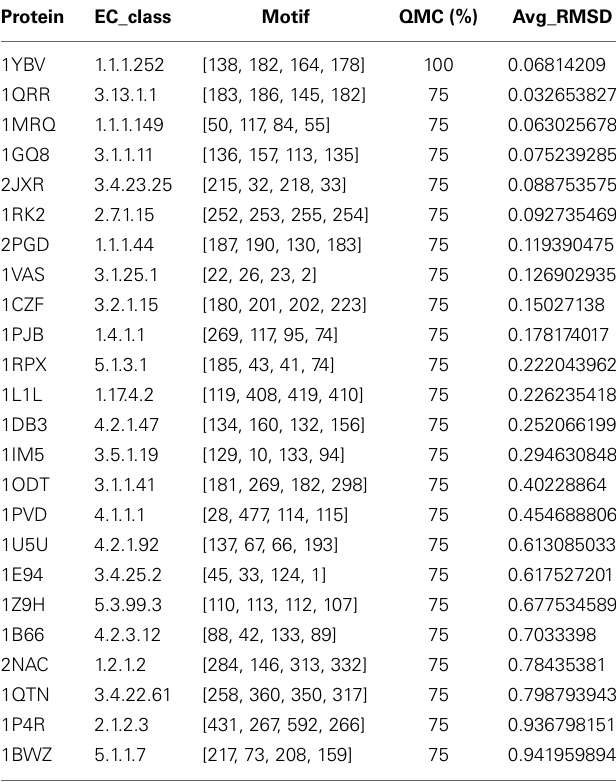
Table 3 | CSA motifs with QMC ≥ 75%. algorithm (query motif coverage), together with the quality of the alignment (RMSD